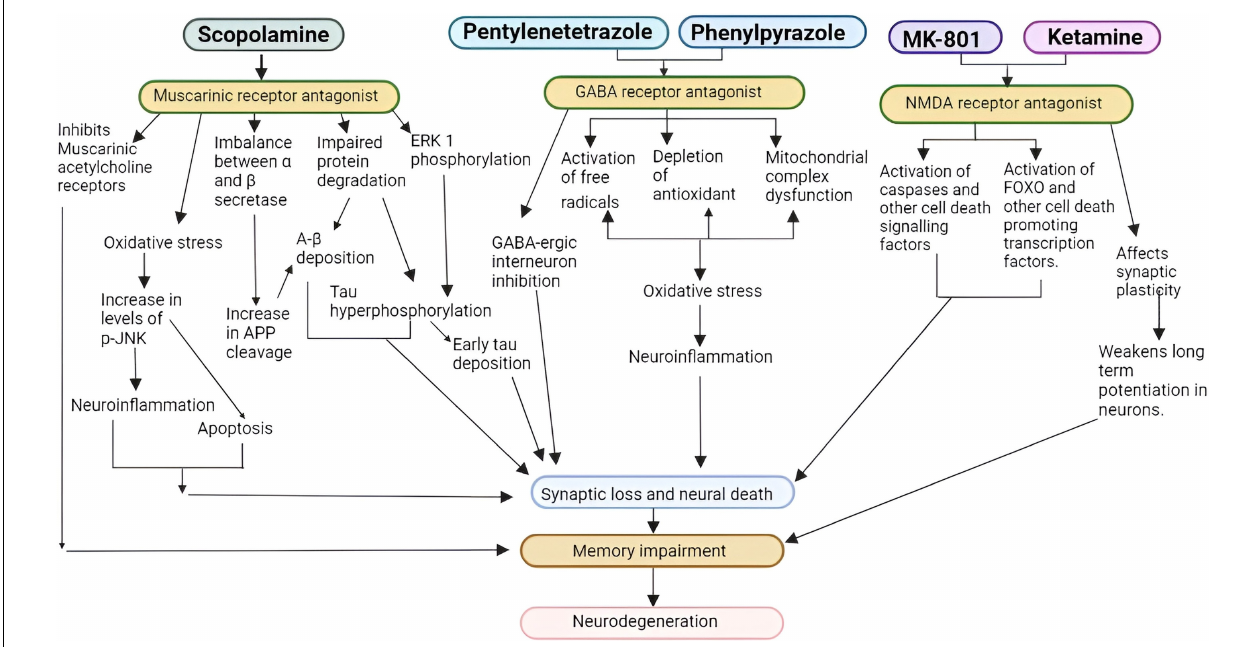
FIGURE 2 | Pathways for cholinergic, glutamatergic, and GABAergic inducers (FOXO, forkhead box transcription factor, p-JNK, p-Jun N-terminal kinase, APP, amyloid precursor protein, NMDA, N-methyl-D- aspartate, GABA, γ -amino butyric acid ERK1, Extracellular signal-regulated kinase 1) (Guan, 2008; Chen and Yeong,